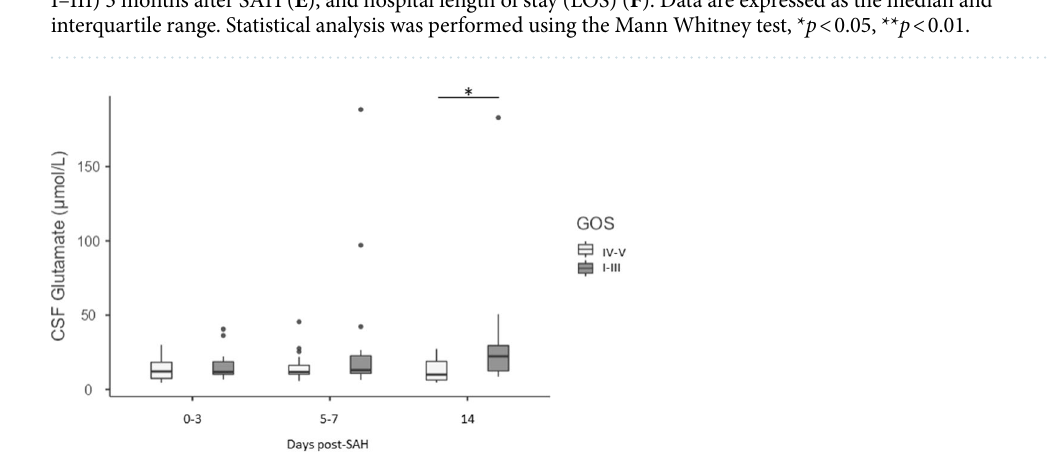
Figure 4. Correlations between CSF glutamate levels and clinical outcome Correlation between CSF glutamate levels at days 0–3, 5–7, and 14 post-SAH and outcome defined as “good” (GOS IV–V) versus “poor” (GOS I–III). Data are expressed as the median and interquartile range. Statistical analysis was performed using the Mann–Whitney test. * p <